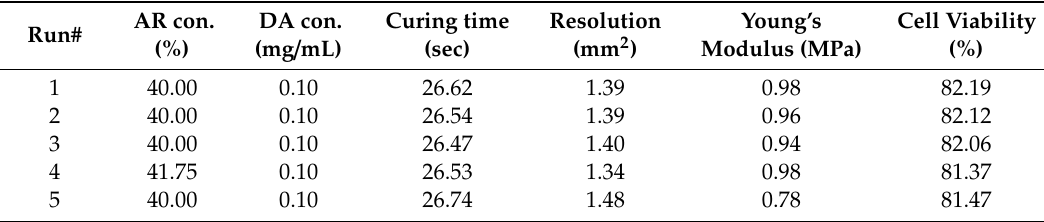
Table 4. The optimal factor-level combination.